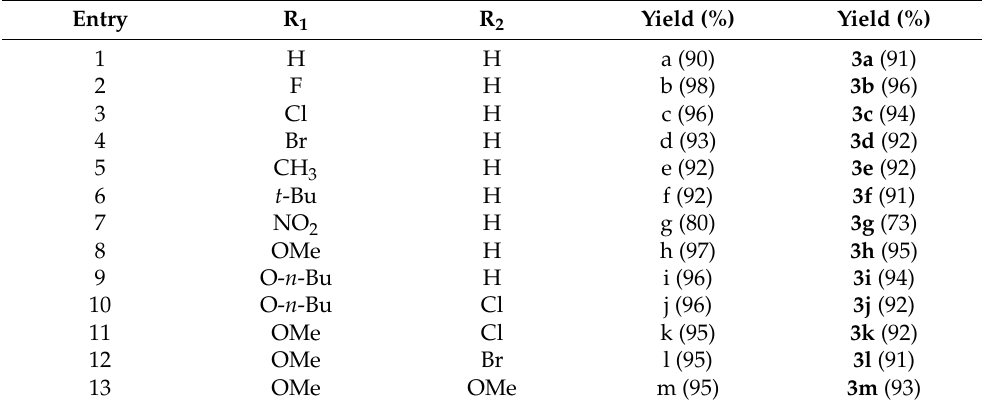
Table 1. Structures and yields of hydroximyl chlorides ( a – m ) and trifluoromethylated flavonoid- based isoxazoles ( 3a – m